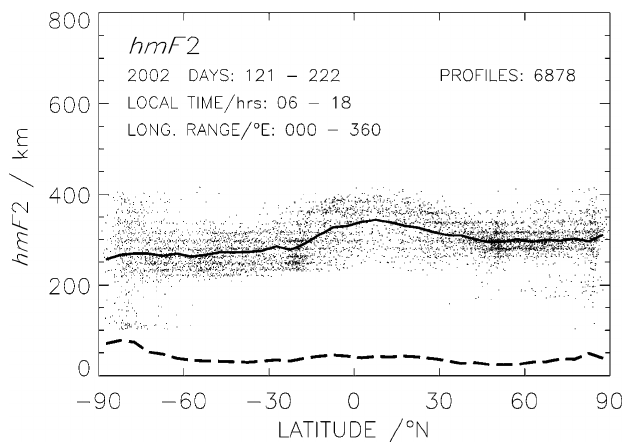
Fig. 7.10. Latitudinal distribution of the height of the peak density. The dashed curve represents the standard